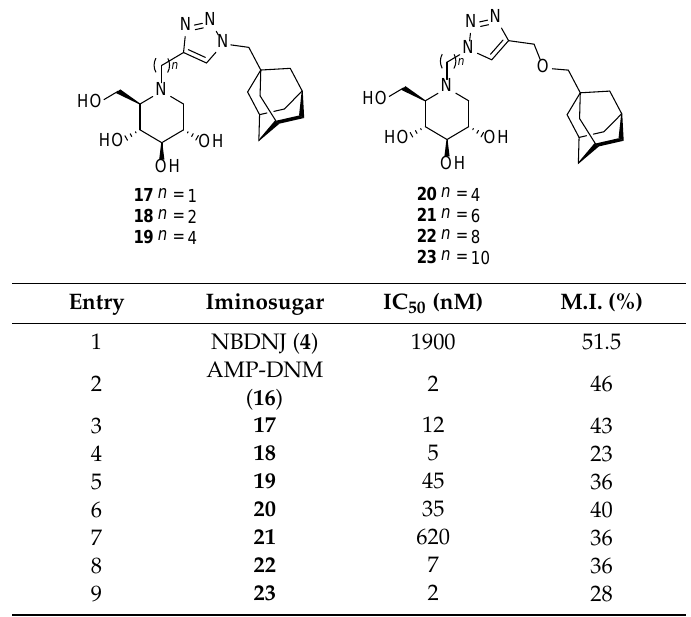
Table 2. Inhibition of P. aeruginosa stimulated IL-8 mRNA expression in CuFi cells. (Reproduced from [176]). Int. J. Mol. Sci. 2020 , 21 , x FOR PEER REVIEW 21 of 35